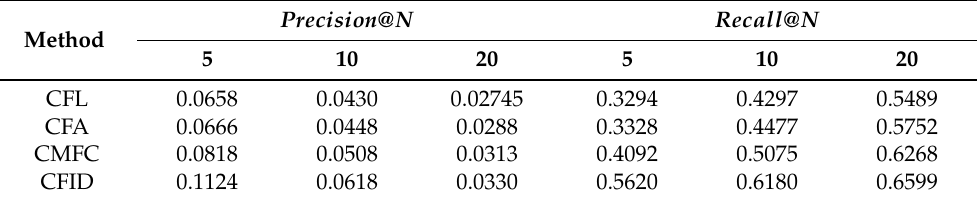
Table 3. Comparative results for two-person group on New York City dataset